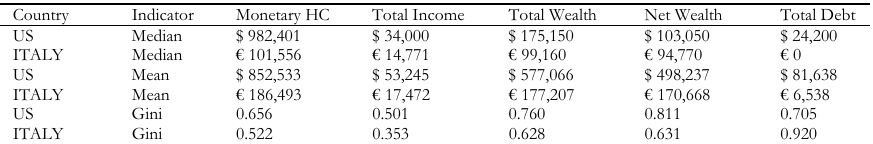
Statistics of HC, Income, Wealth and Debts (€ and